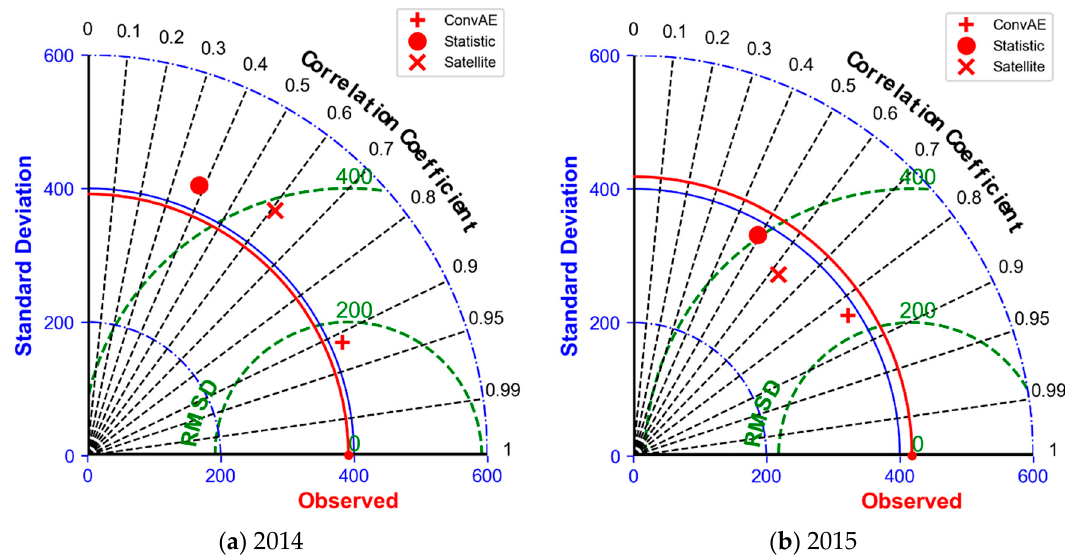
Figure 11. Taylor diagram showing the correlation coefficient, standard deviation, and root mean square deviation (RMSD) from the precipitation products based on the observed, ConvAE, statistic, and satellite, respectively.